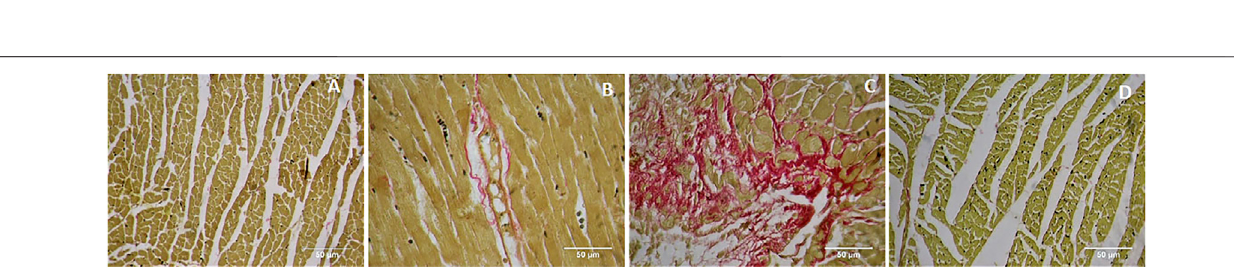
FIGURE 9 | Histopathology of heart tissue stained with Picrosirius red (40 × ). (A) Control rat shows the normal distribution of collagen. (B) GA alone treated rat showsthenormaldistributionofcollagen. (C) ISO-controlratshowsendocardialcollagenaccumulation(redcolour). (D) PretreatmentwithGAshowedreducedcollagen deposition in the